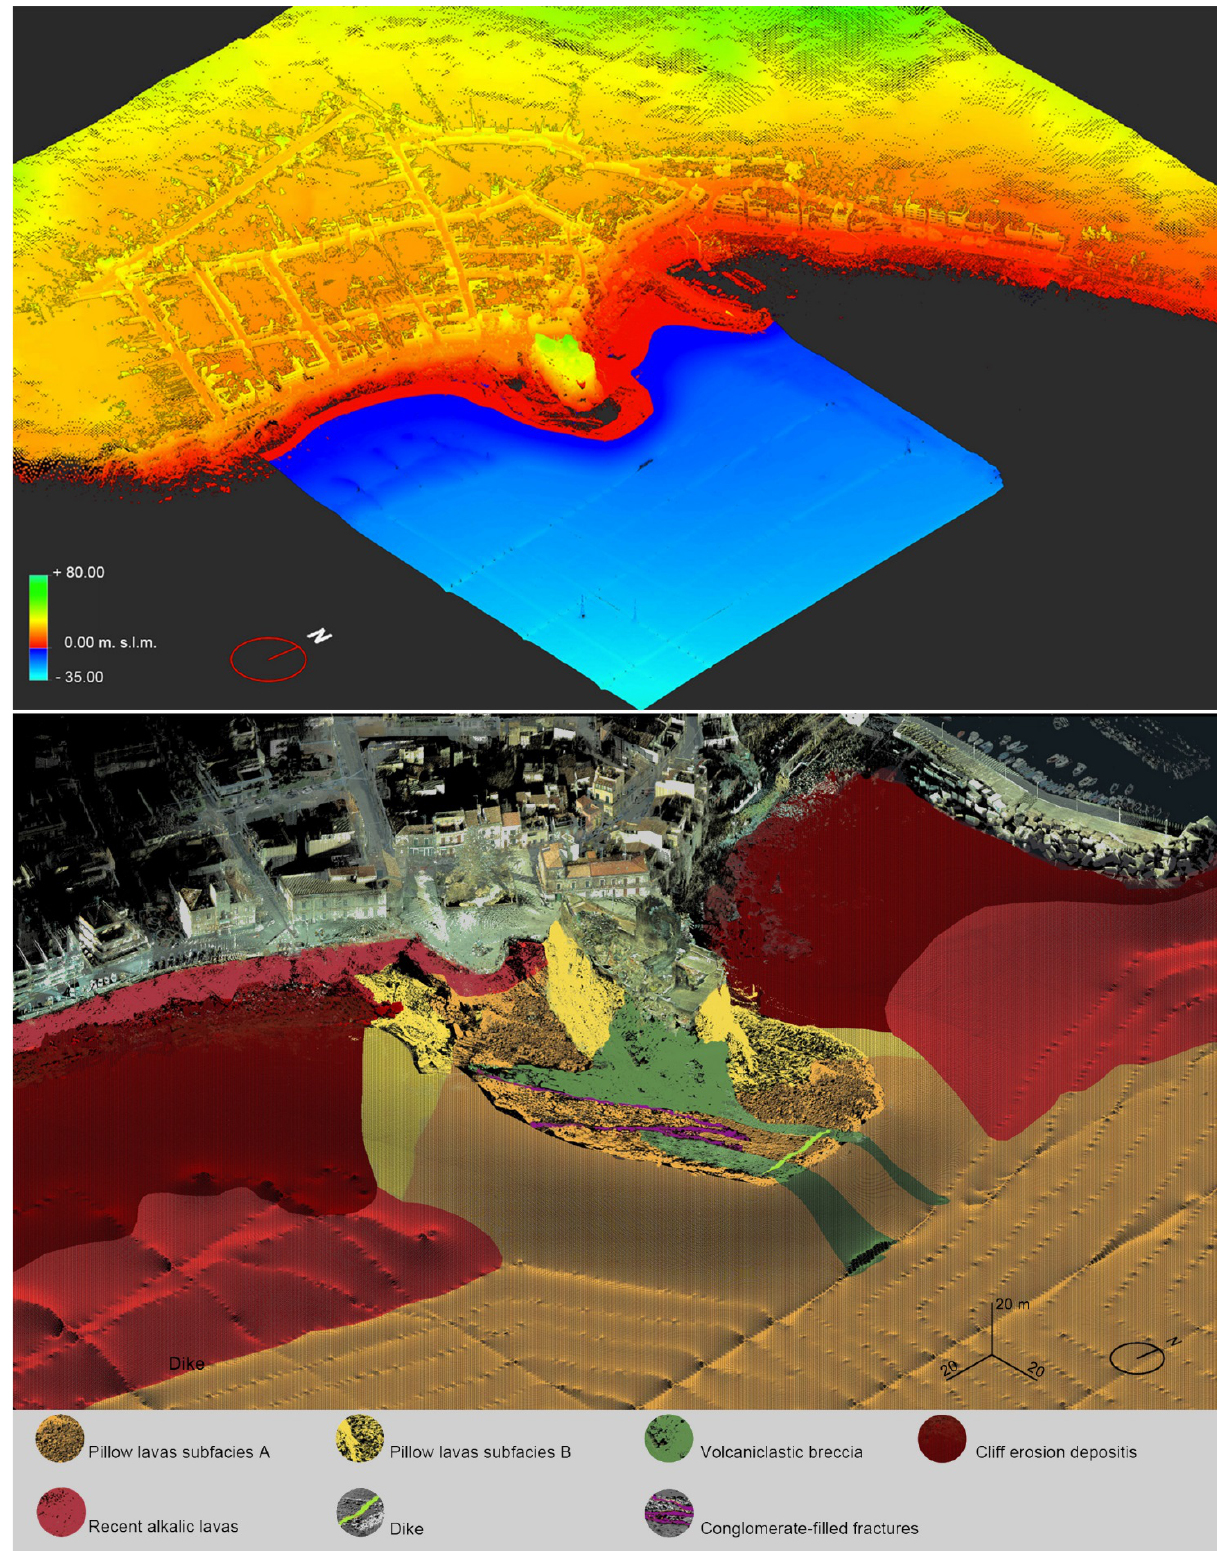
Figure 3: Multi-thematic readings of the Aci Castello coastal site: above, 3D elevation map; below, 3D geological